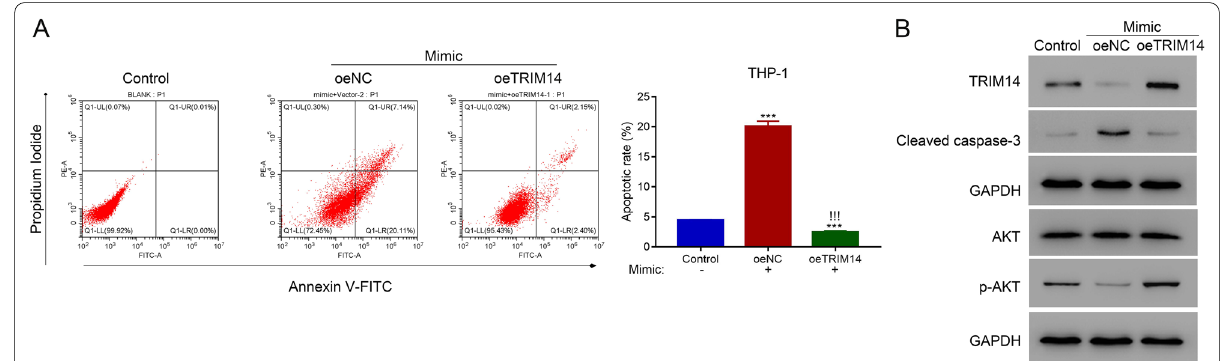
Fig. 6 Overexpression of TRIM14 suppressed the function of miR-23a-5p in AML cells. A Flow cytometry detected the apoptosis of THP-1 cells after transfecting with TRIM14 overexpressed plasmid and control plasmid in the presence of miR-23a-5p mimic. B The expression of TRIM14, cleaved caspase-3, AKT and p-AKT after transfecting with TRIM14 overexpressed plasmid and control plasmid in the presence of miR-23a-5p mimic. *** p < 0.001; !!!*** p < 0.001 vs oeNC +